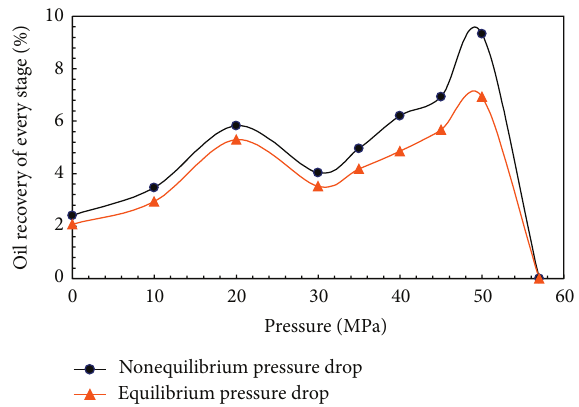
Figure 3: The condensate oil recovery under each pressure point in the equilibrium pressure drop and nonequilibrium pressure drop constant volume depletion